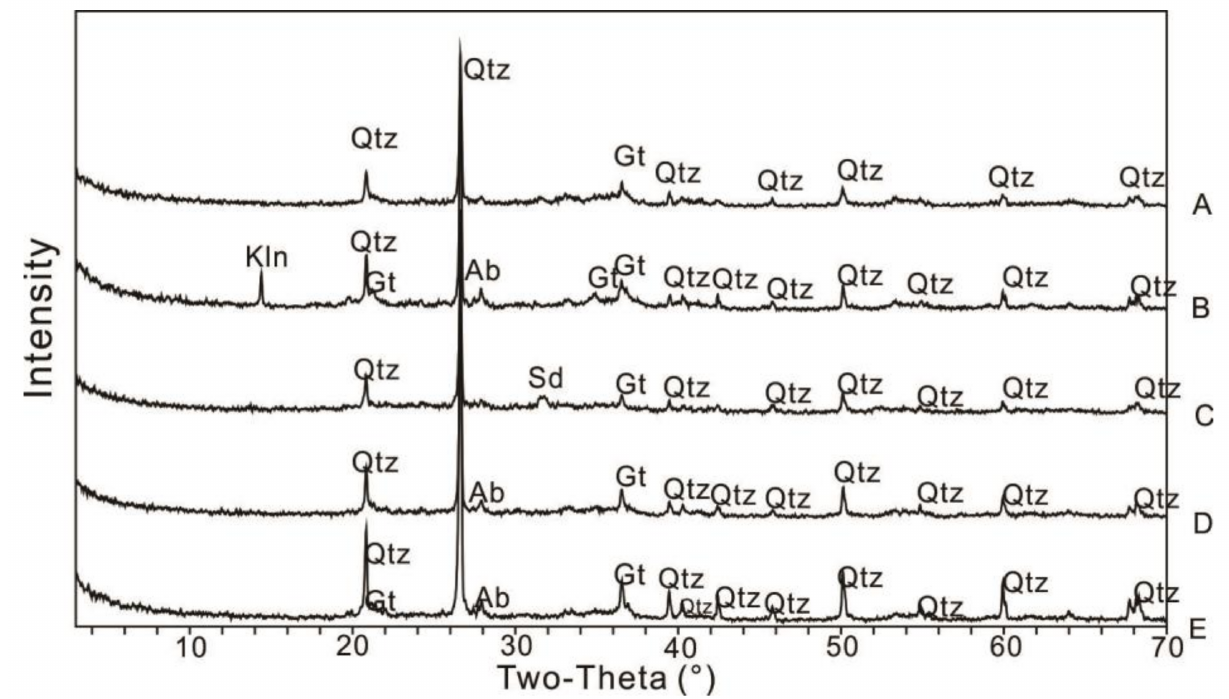
Figure 5. XRD profiles from five samples. Samples A and E were collected from Pingtaishan Island, sample B from the lake bottom near Xishan Island and samples C and D from the Shihu lake bottom. Qtz stands for quartz, Kln for kaolinite, Sd for siderite, Gt for goethite and Ab for